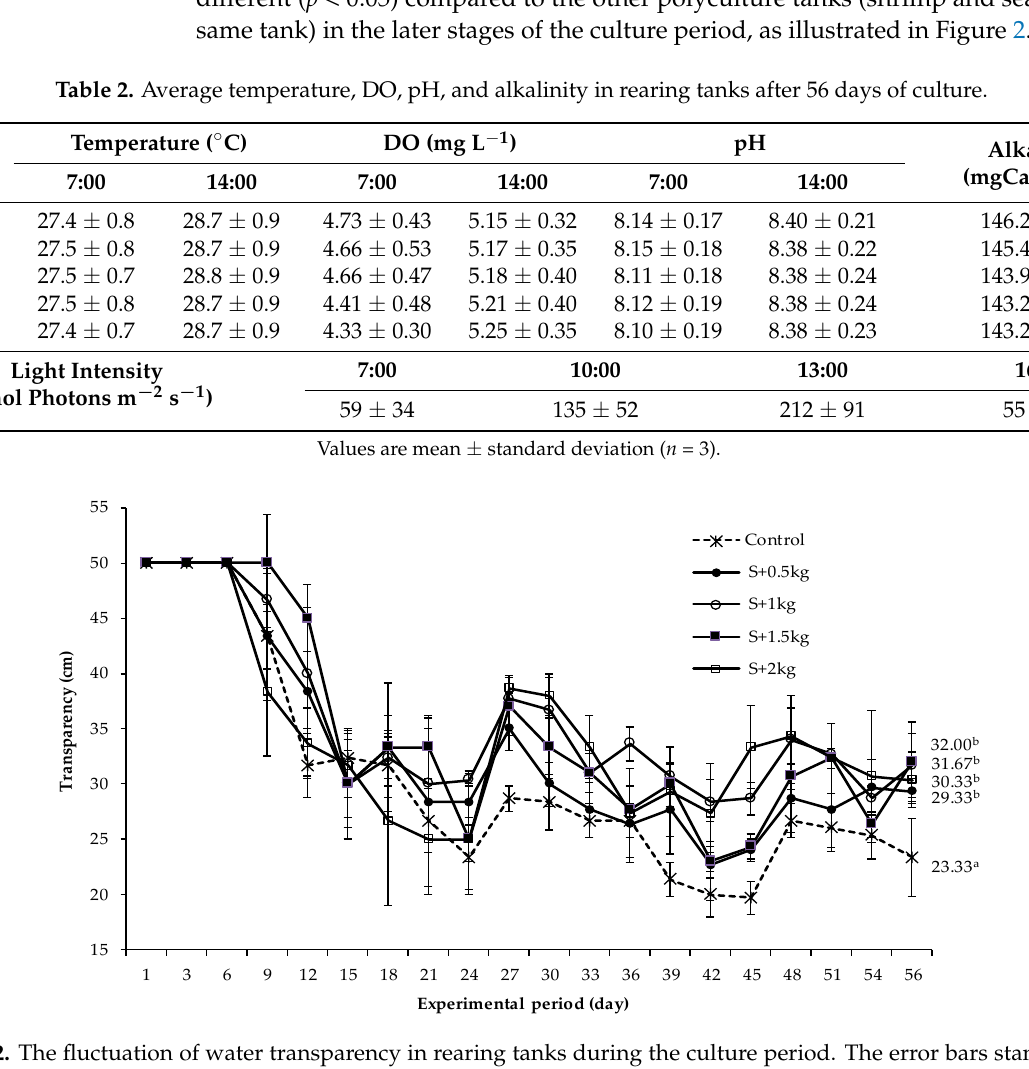
Table 2. Average temperature, DO, pH, and alkalinity in rearing tanks after 56 days of culture. Temperature (°C)